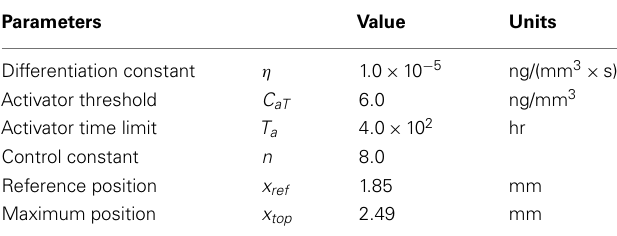
Table 2 | Model parameters in cell differentiation model